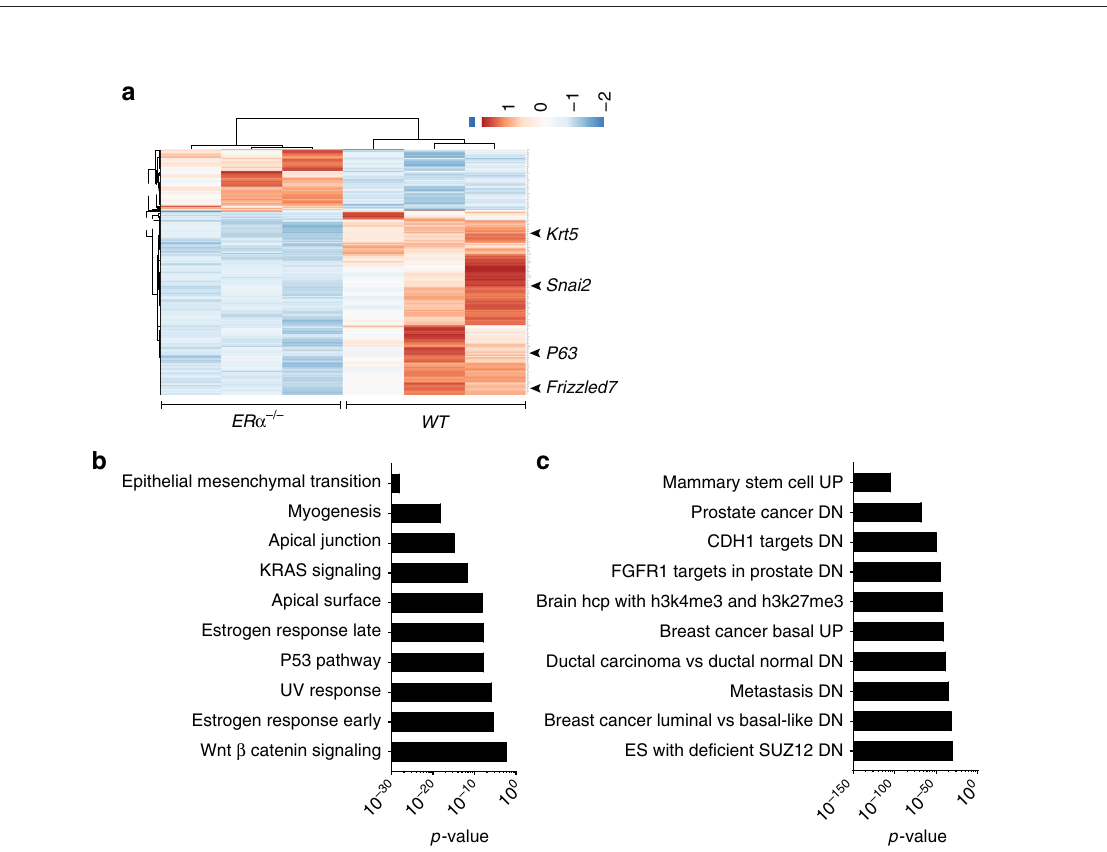
Fig. 8 ER α -mediated control of gene expression signatures. a Heatmap of RNAseq transcriptomic analysis of WT.GFP + and ER α − / − .GFP + MECs that grew intraductally in NSG females contralateral glands. Row Z scores of genes that were differentially expressed are included. b , c Gene set enrichment analysis of genes that were down-regulated, in in ER α − / − .GFP + MECs compared to WT.GFP + control cells. By hallmark gene sets ( b ) and curated gene sets ( c ). The most signi fi cantly enriched terms with p values are listed